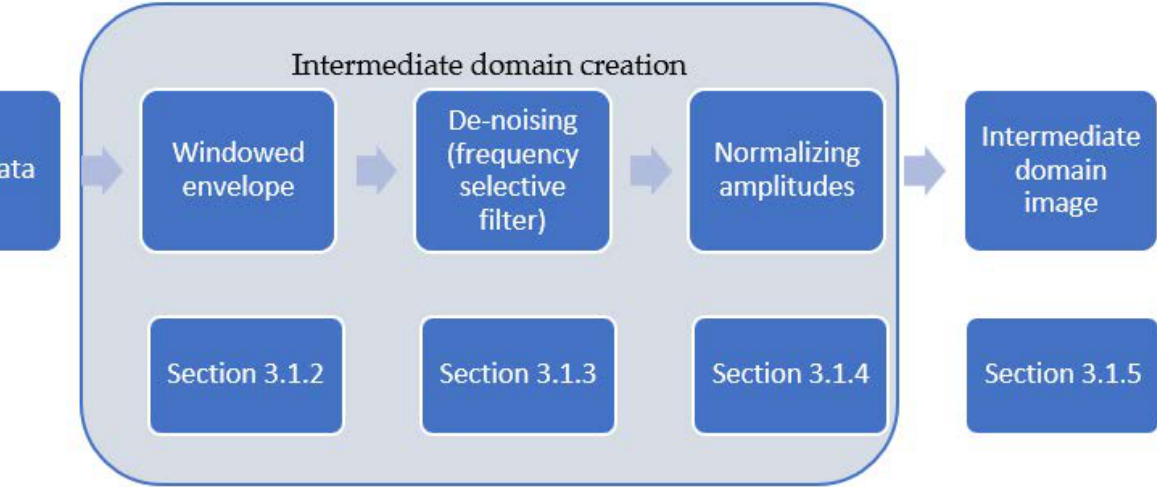
Figure 3. The different steps to obtain the proposed intermediate domain image from the raw sensor